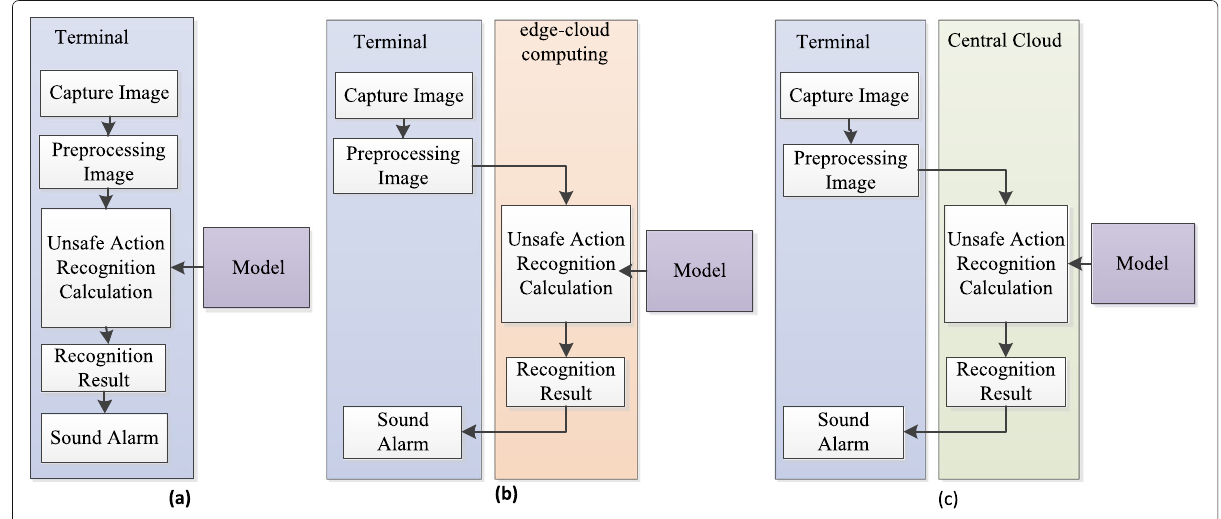
Fig. 8 Three execution modes. a Detection at the Terminal ( b ) Detection in Edge Computing ( c ) Detection in Central Cloud